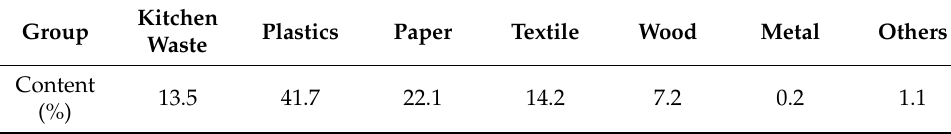
Table 1. Composition of household waste as a percentage (dry basis). Group